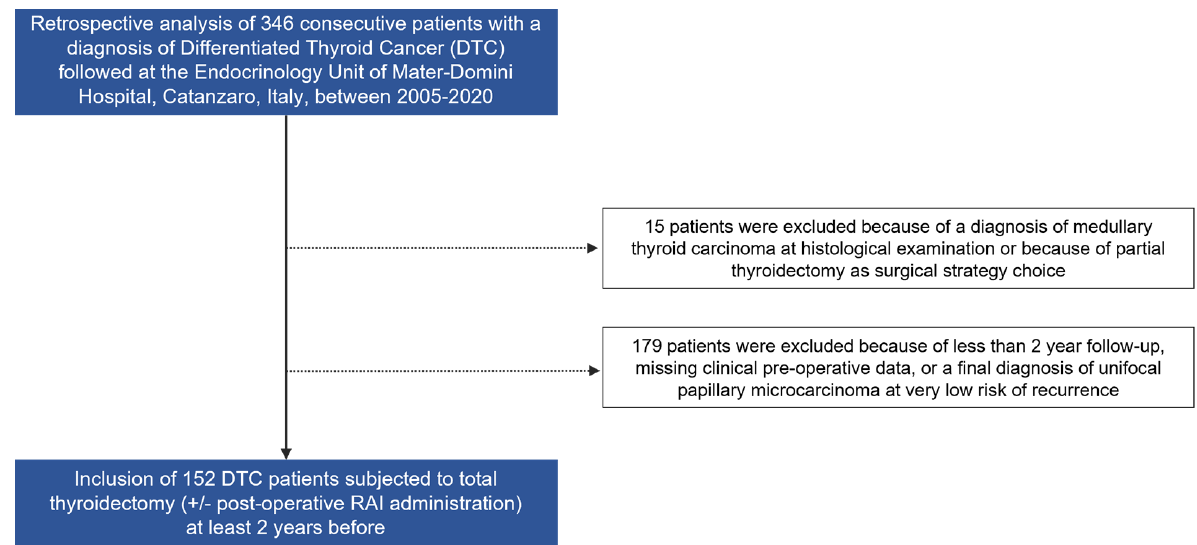
Figure 1. Participant selection workflow.